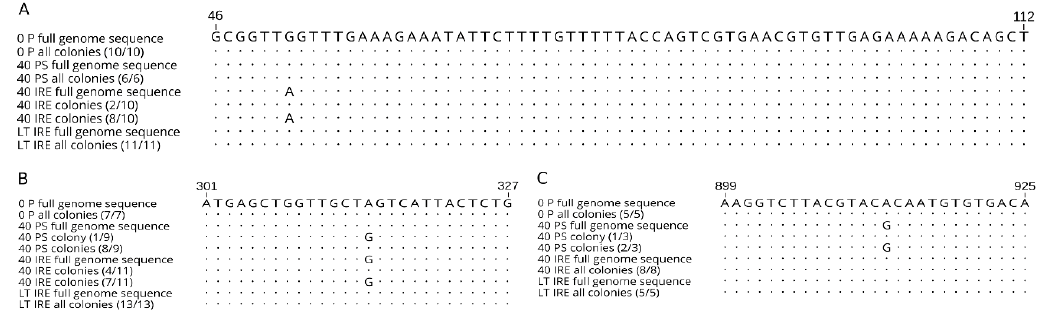
Figure 5. Comparison of partial nucleotide sequences of ( A ) 5 ’ UTR, ( B ) C protein, and ( C ) E protein among clones derived from parental tick-borne encephalitis virus (0 P) and virus variants 40 PS, 40 IRE, and LT IRE. Numbers in parentheses represent the frequency of a particular substitution among the sequenced clones. Dots represent conserved nucleotides, letters indicate substitutions.